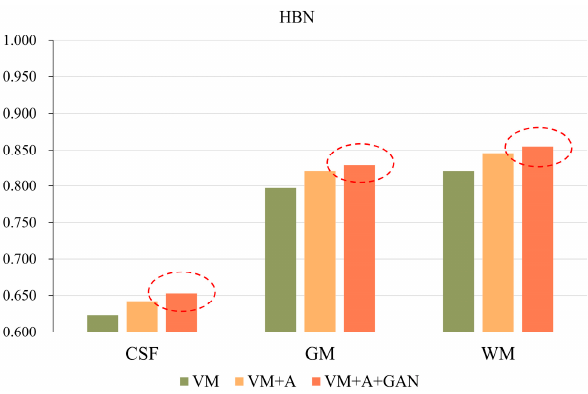
Figure 5. GAN registration performance on the HBN dataset.